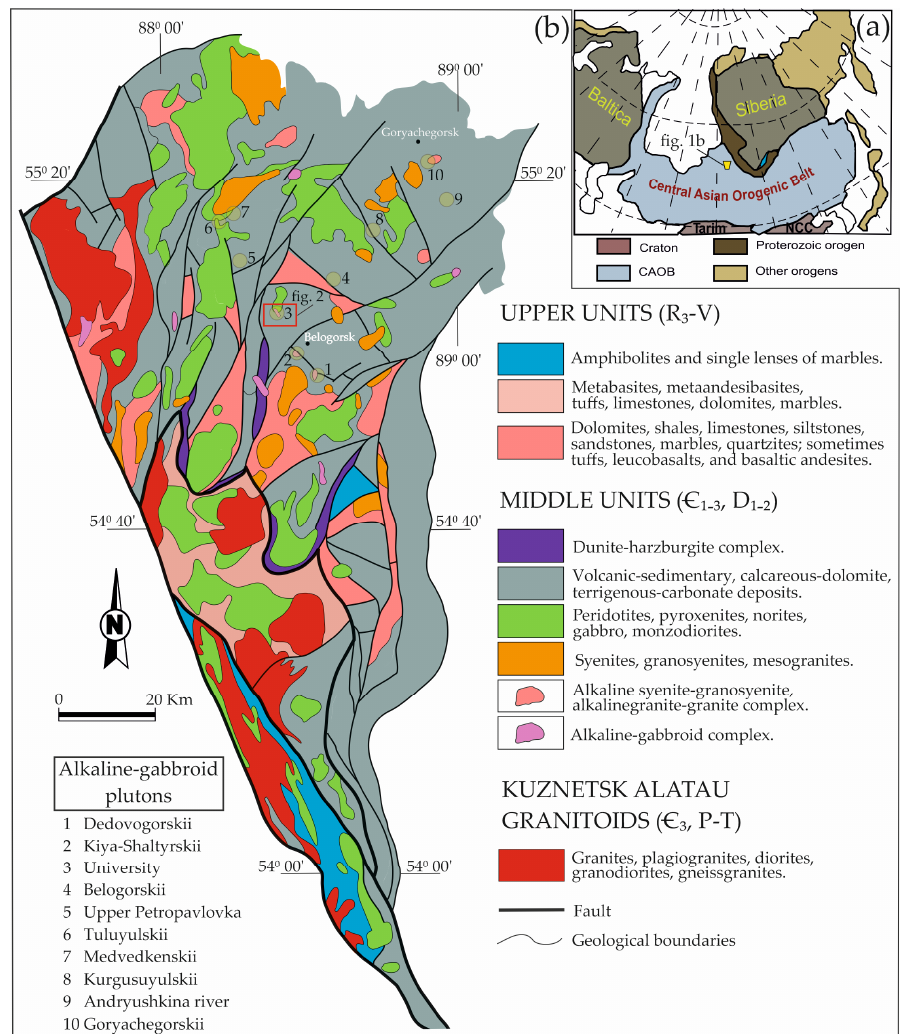
Figure 1. Simplified scheme of the Central Asian orogenic belt ( a ) after [34,49,50] with a fragment of the geological map of the northern part of the Kuznetsk Alatau (KA) ridge and ( b ) after [51] with changes and additions by the authors. Red box locates Figure 2 and Figure